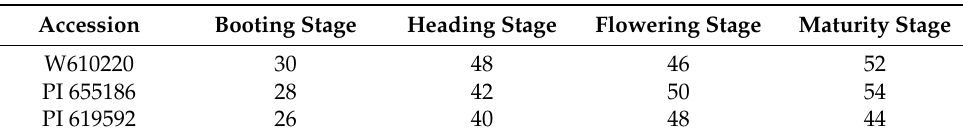
Table 2. The number of protruding barbs within the awn length of 2 mm at four stages of three accessions.